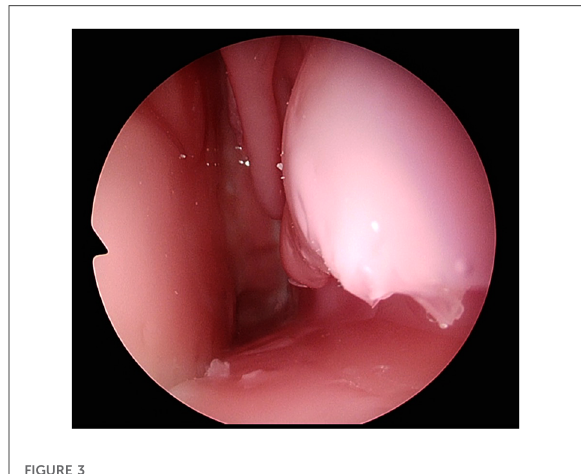
FIGURE 3 Participant identifying choana and nasal turbinate ’ s on the TNS Box.